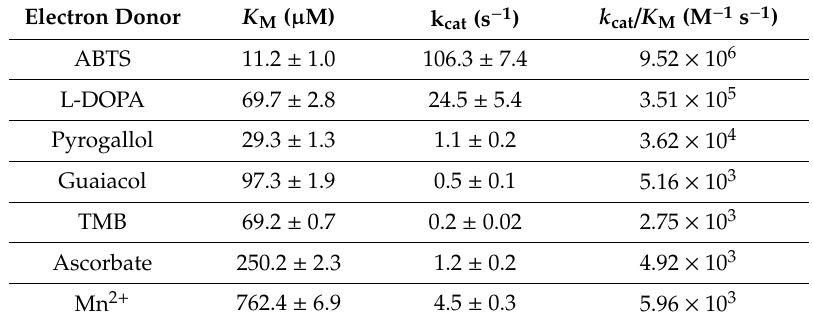
Table 4. Michaelis–Menten parameters of purified MoHyBPOX1 for selected electron donors *.